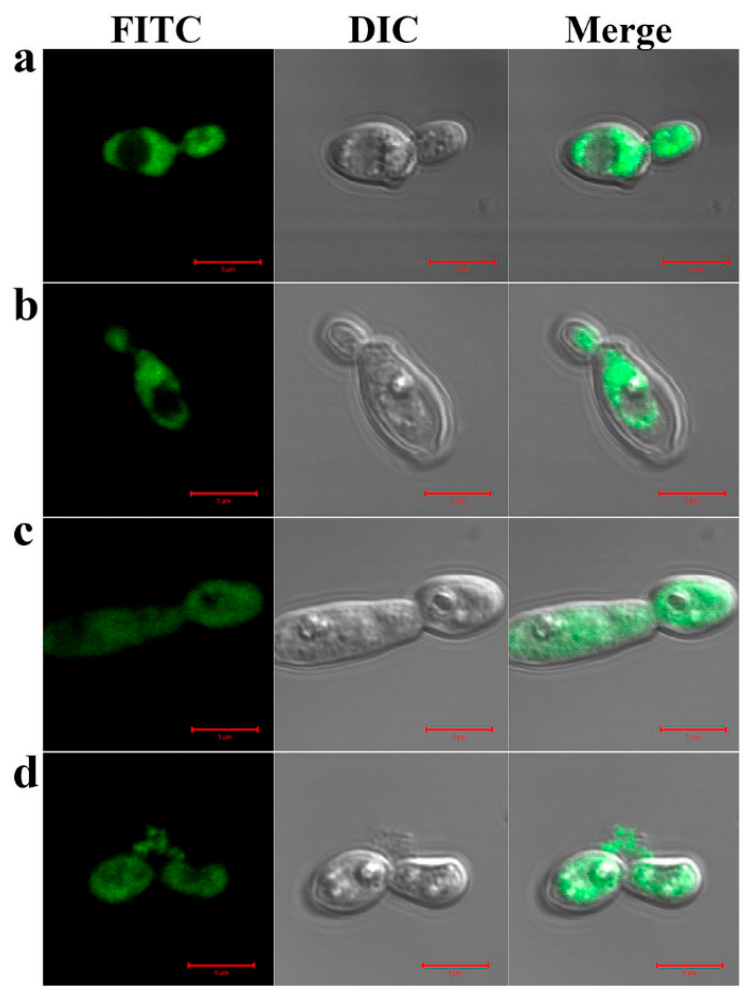
Figure 2. Cellular distribution of Trx-H2/H3/2N3C/3N2C proteins in C. gloeosporioides cells. FAM-labeled Trx-H2 ( a ), -H3 ( b ), -2N3C ( c ), or -3N2C ( d ) proteins were incubated with spores of C. gloeosporioides at corresponding minimum inhibitory concentrations (MICs) in pH 5.2 for 2 h at 28 °C, following which, cellular populations of FAM-labeled proteins were observed under a confocal laser scanning microscope.